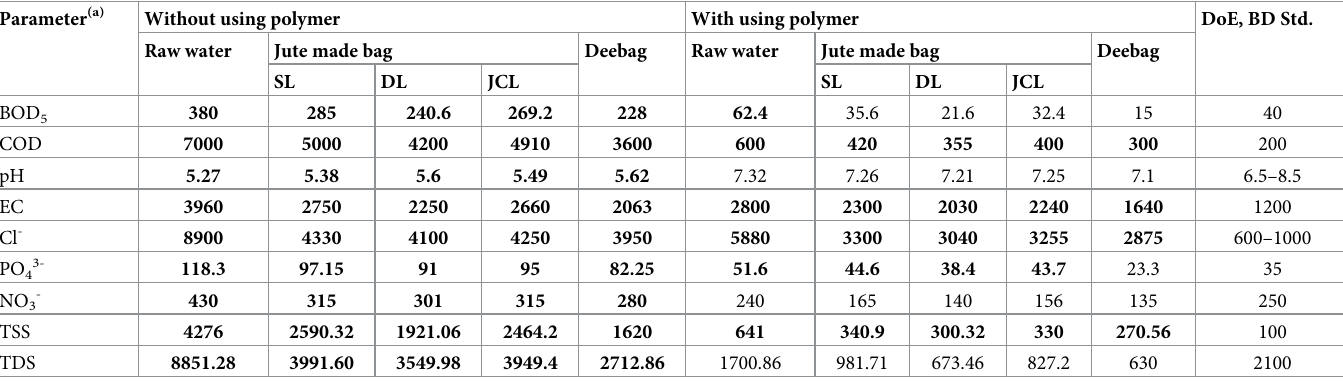
TDS 8851.28 (a) All values except pH and EC are expressed in mg/L and EC is expressed as μ S/cm. S = Single Layered; DL = Doubled Layer; JCL = Jute & Cotton Layered; DoE, BD Std. = Department of Environment, Bangladesh Standard.